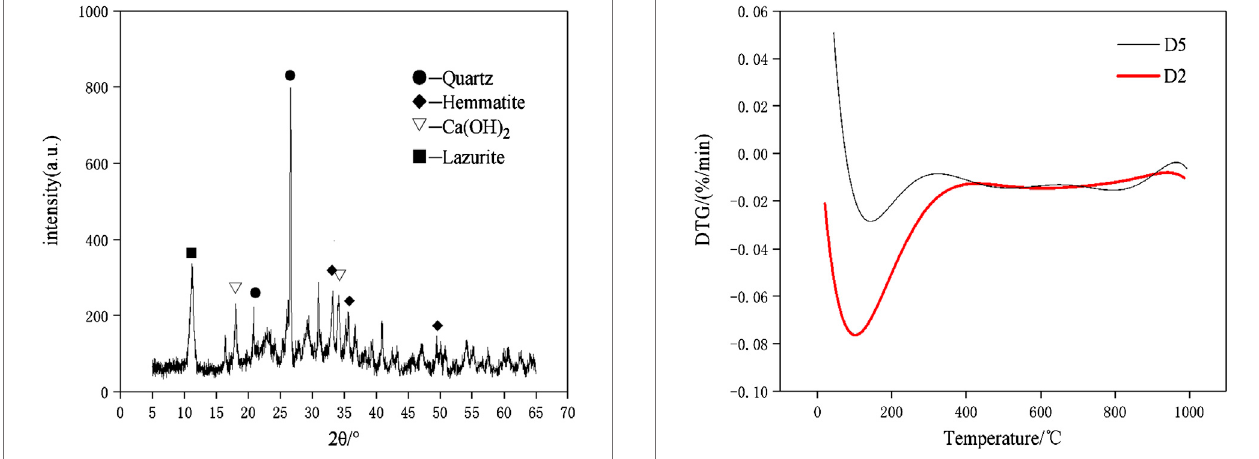
FIGURE 13 | DTG patterns of paste specimens of D2 and D5